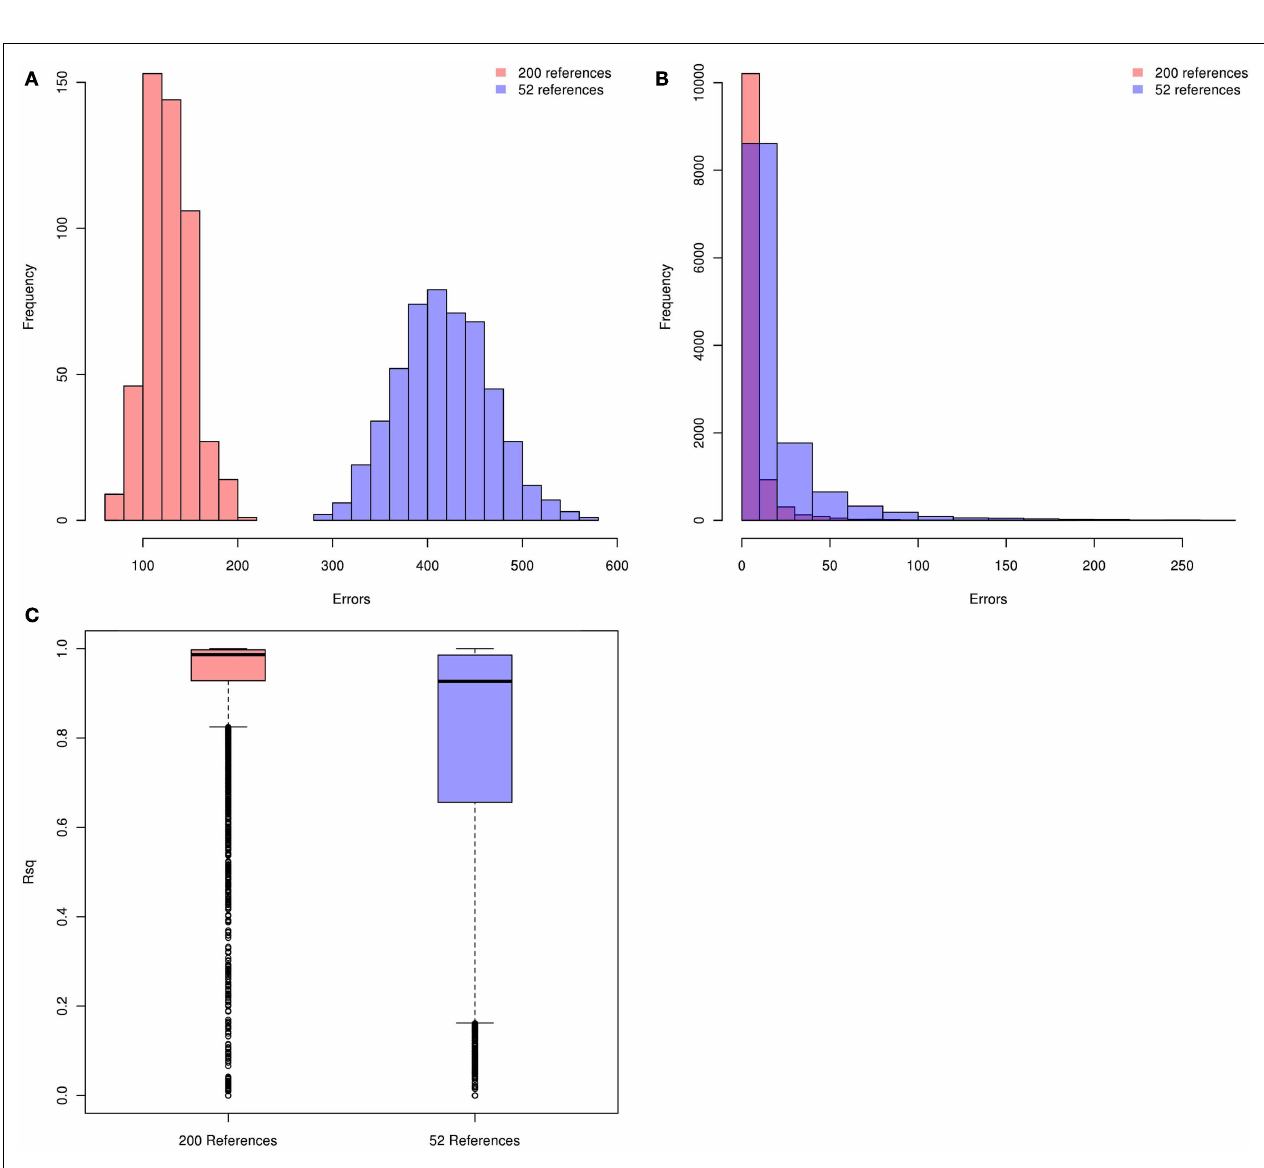
FIGURE 1 | Distributions of per individual and per SNP errors and the imputed MACH Rsq. Pink and blue denote the 200-individual and 52-individual reference panels, respectively. Genotype imputation accuracy is tested in an additional 500 simulated individuals.The true